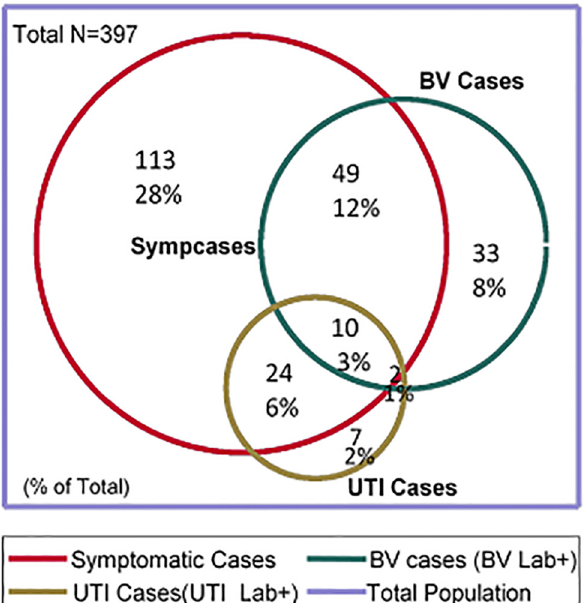
Fig 2. Venn diagram showing distribution of participants according to the different outcomes groups.